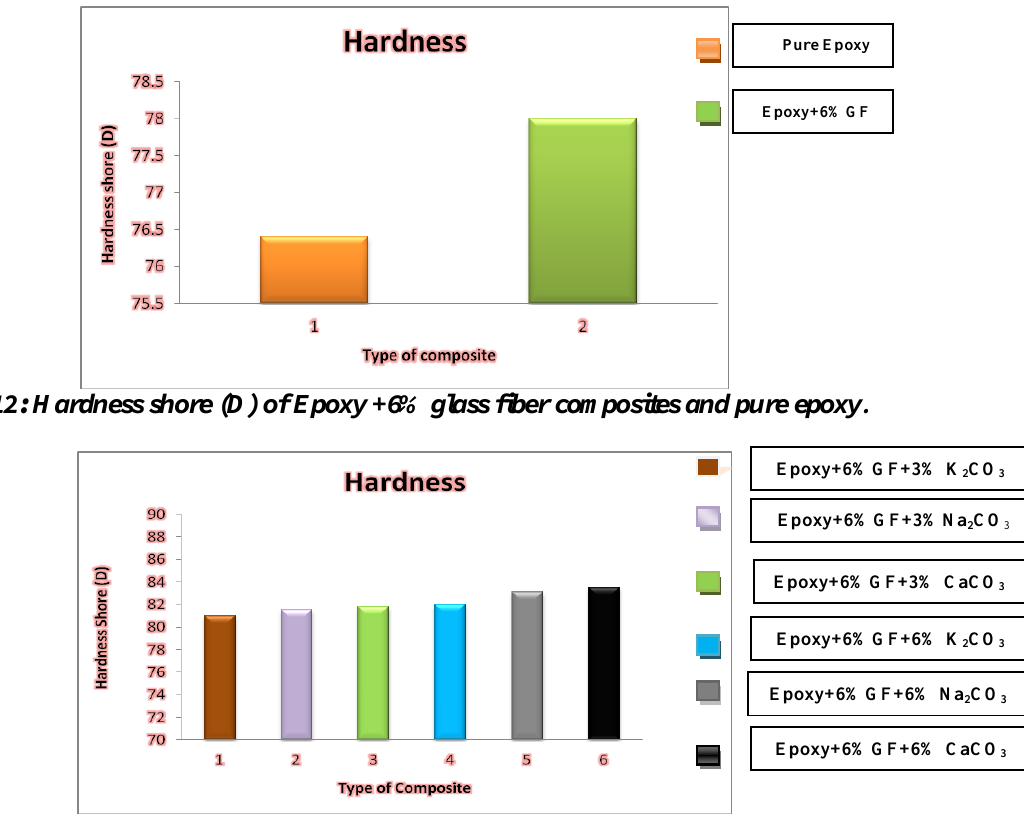
Fig.13: Hardness shore (D) of industrial composites